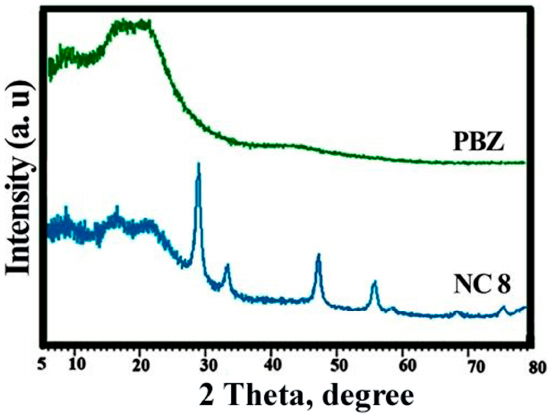
Figure 5. XRD diffraction patterns of PBZ and NC 8.